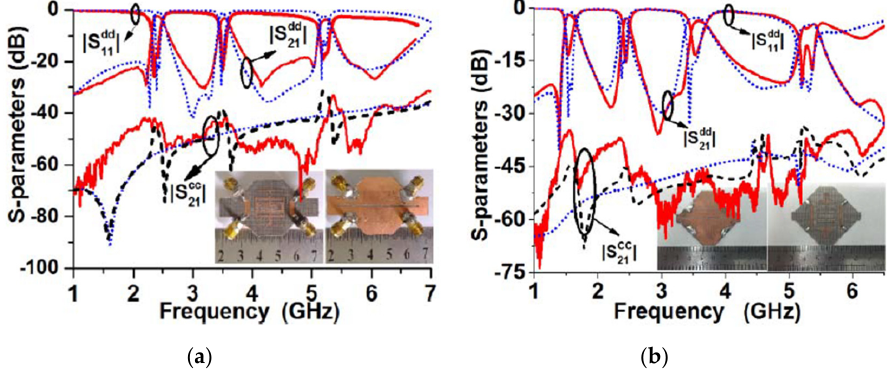
Figure 16. Simulated and measured results and photographs of the prototypes [77]: ( a ) Tri-band differential-fed BPF; ( b ) Quad-band differential-fed BPF.